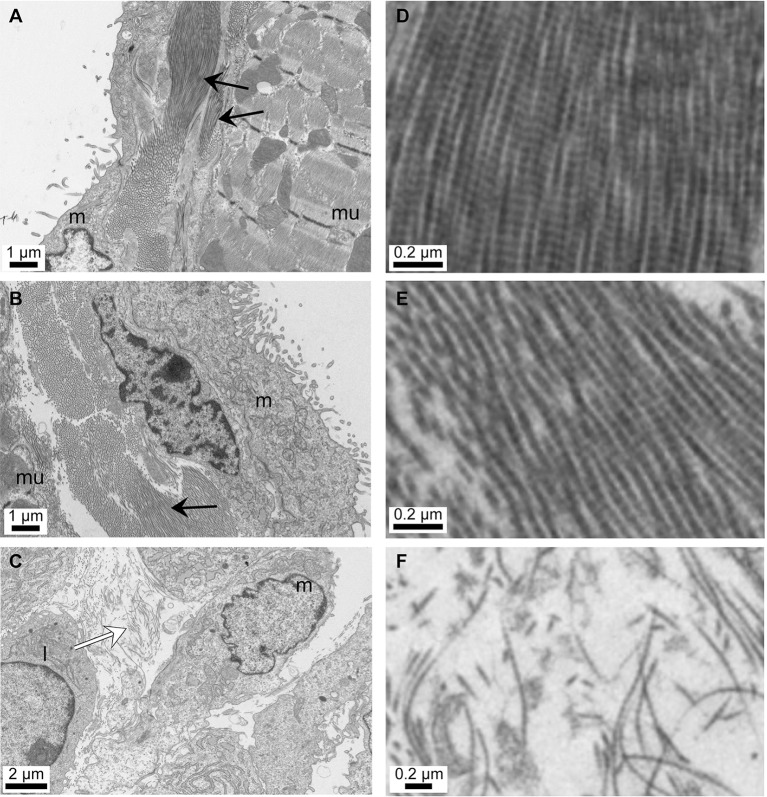
Electron micrographs of mouse diaphragm showing effect of NT and BAPN on sub-epithelial collagen deposition.A,D PBS control; B,E 7 days after NT treatment; C,F 7 days after NT plus daily β-aminopropionitrile (BAPN) treatment. m: mesothelial cells, mu: muscle fibres, l: probable leukocyte. ↑ dense, ordered collagen fibre bundles, ⇧ loose, disordered collagen fibres.